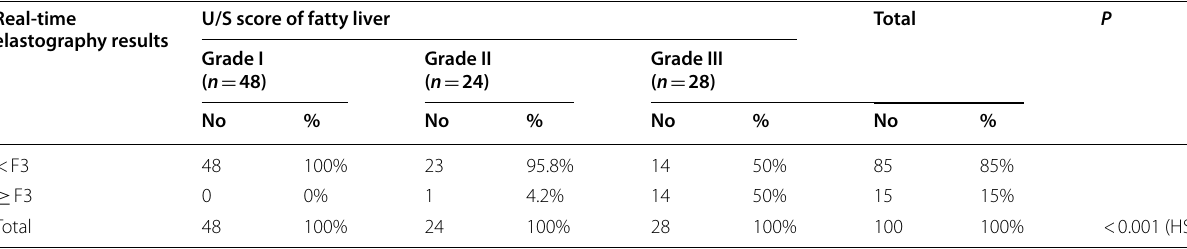
Table 8 Relation between U/S grade of fatty liver and real-time elastography results Real-time elastography results